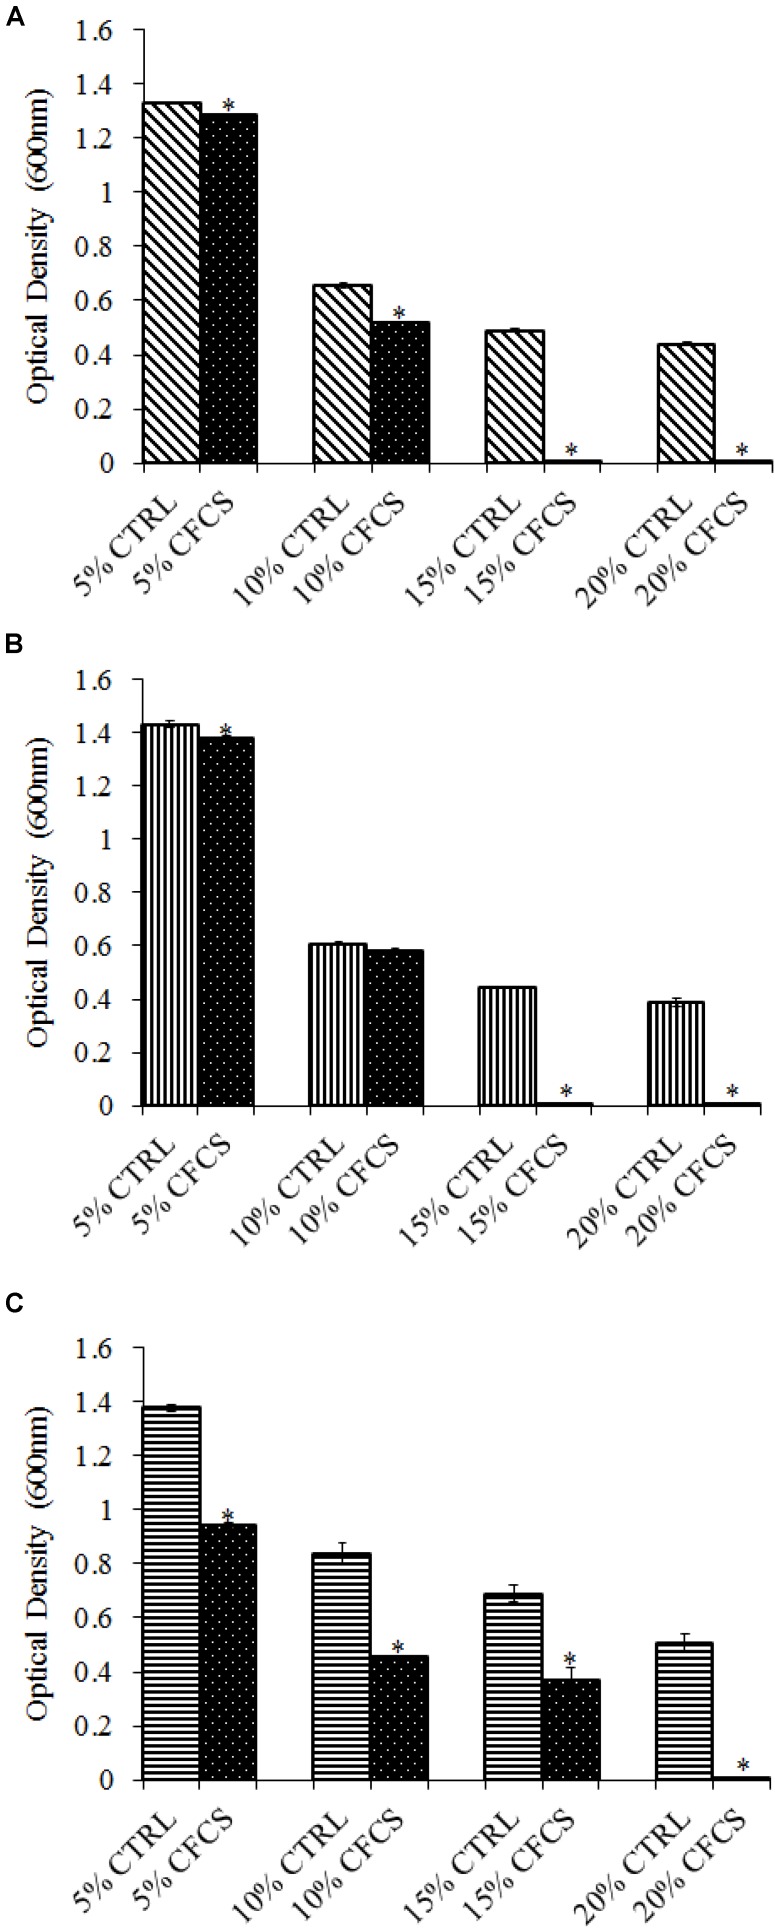
Effect of P. shermanii (PS) CFCS on (A)
S. Heidelberg (B)
L. monocytogenes, and (C)
E. coli O157: H7. TSB containing S. Heidelberg, L. monocytogenes, or E. coli O157: H7 (106 CFU ml−1) were treated with 5, 10, 15, or 20% (v/v) of CFCS of PS. The pH of TSB was adjusted to match the pH of treatments having CFCS were inoculated with the respective pathogen and used as positive CTRL for each CFCS concentration. The pathogen survival was determined by determining optical density (OD = 600 nm) after incubating samples at 41°C for 24 h (n = 6; ∗P < 0.05). Bacterial counts were represented as OD600 ± standard error.